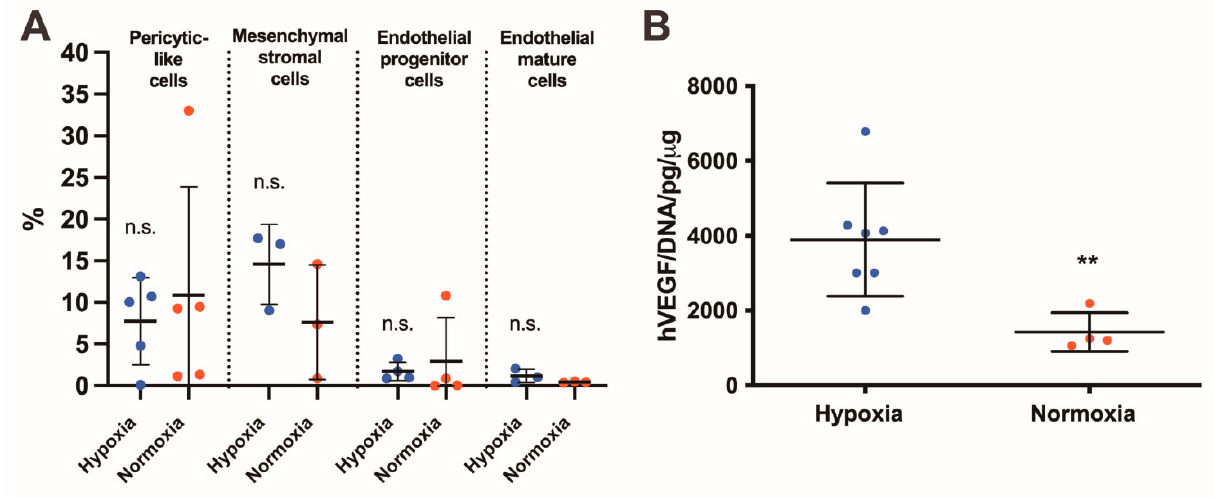
Figure 4. In vitro characterization of stromal vascular fraction (SVF)-based constructs. SVF composition and angiogenic factor release. ( A ) Flow cytometry analysis: percentage of different SVF subpopulations, namely, pericytic-like (CD45 − , CD34 − , CD146 + ), mesenchymal stromal cells (MSC, CD45 − , CD90 + , CD73 + ), and endothelial progenitor (CD45 − , CD31 + , CD34 + ) and mature (CD45 − , CD31 + , VEGFR2 + ) cells, following 3D perfusion-based culture in in vitro normoxia or hypoxia. Values are presented as percentage of living cells. n.s. = not statistically significant. n = 5. ( B ) Quantification of human VEGF released in the supernatant by SVF cultured under severe hypoxia or normoxia culture normalized by the total DNA content. ** p < 0.001. n = 4. hVEGF: human vascular endothelial growth factor; DNA: desoxyribonucleic acid. Comparison was performed with non ‐ parametric test (Mann–Whitney ‐ U).